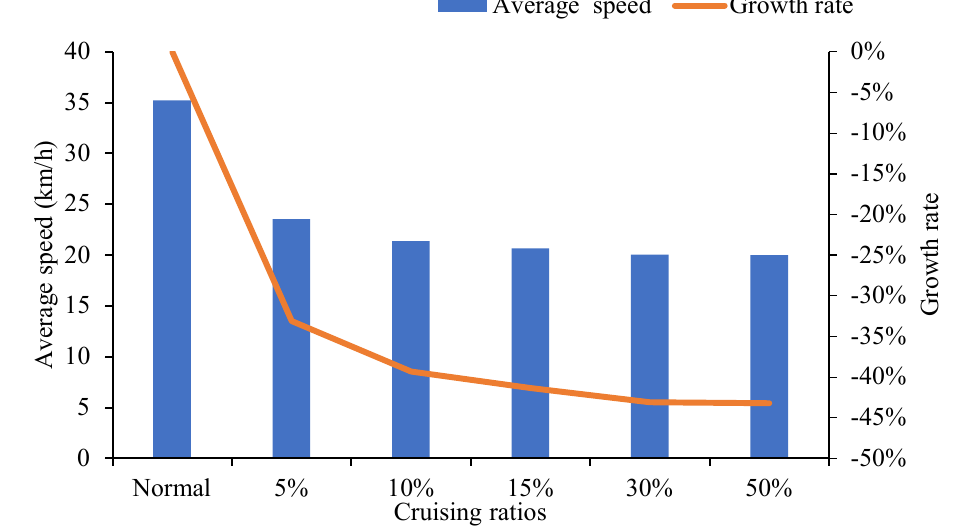
Figure 15. Comparison of average speed at road network.